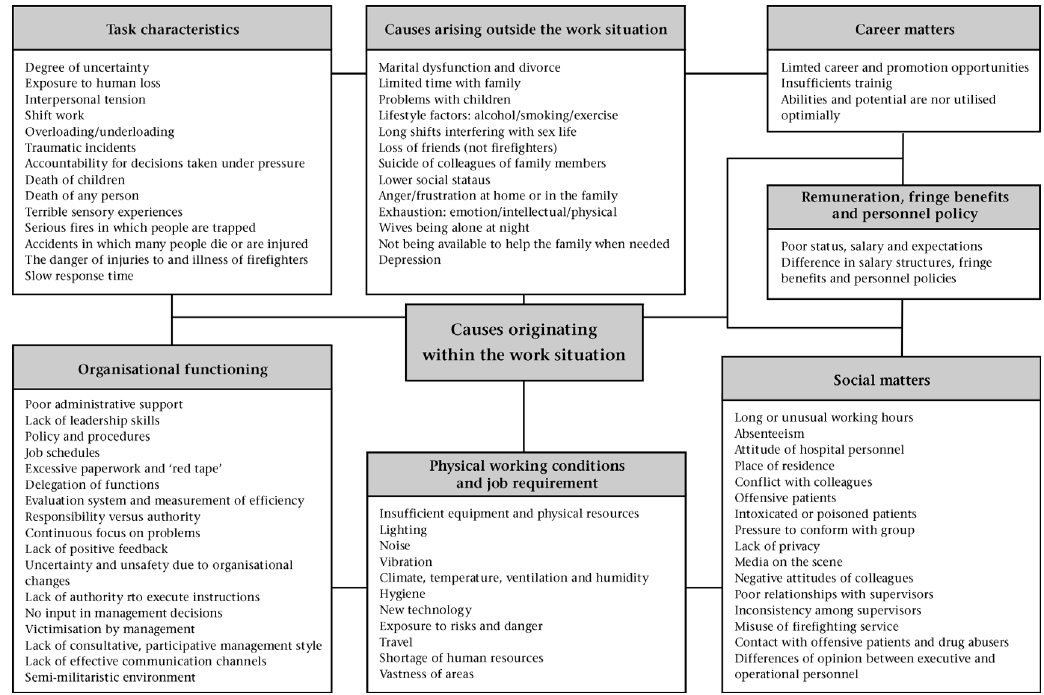
Figure 1: Model of job stressors of firefighters (Kootzen, 1996; Shakespeare-Finch et al., 2002; Waters,